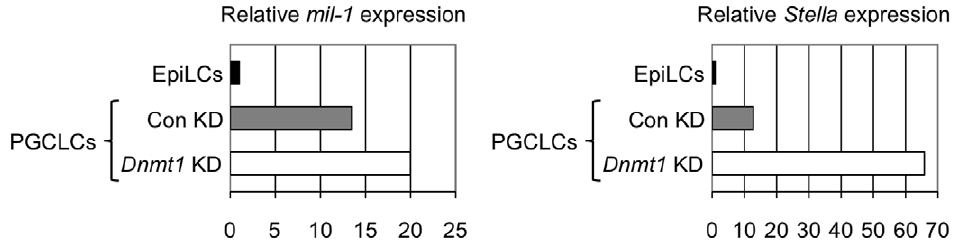
Figure 6. Knockdown of Dnmt1 causes upregulation of mil-1 and Stella expression in PGCLCs. Quantitative RT-PCR analysis of mil-1 and Stella expression in PGCLCs (PGC-like cells) with or without Dnmt1 knockdown ( Dnmt1 KD/Con KD). The expression level in EpiLCs was set as 1.0. Shown is a representative data from two independent experiments.